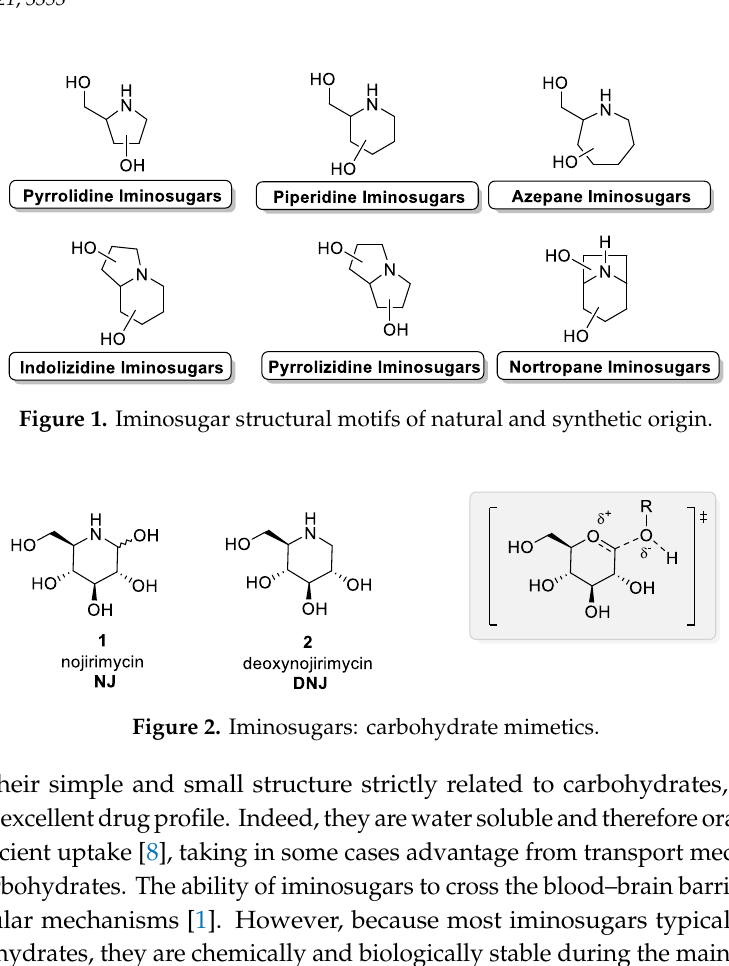
Figure 2. Iminosugars: carbohydrate mimetics.